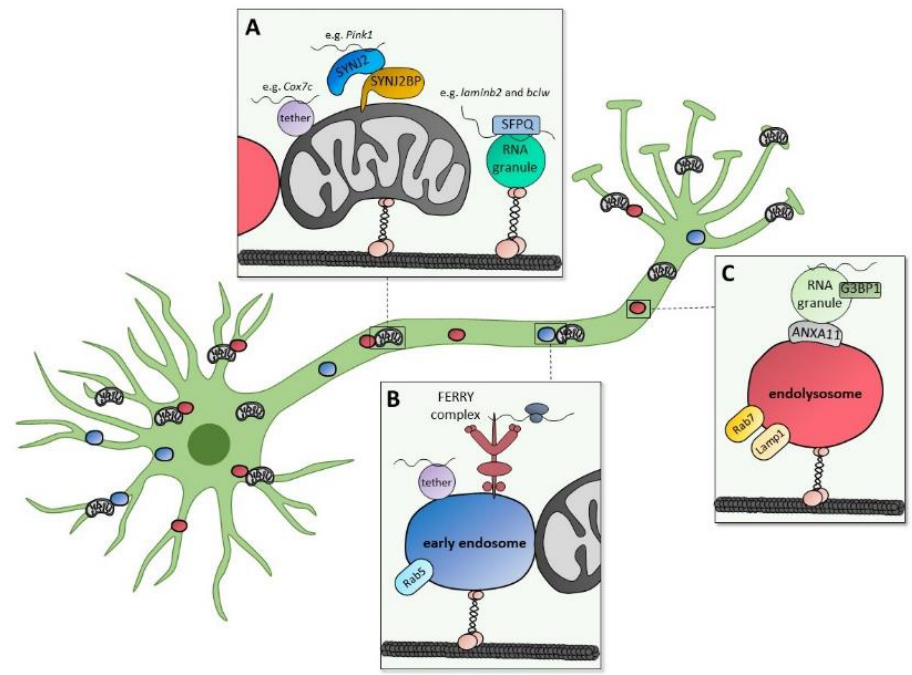
Figure 2. Transport of nuclear-encoded mitochondrial transcripts in neurons. Motor proteins actively transport RNA granules, mitochondria and Rab5-positive early endosomes as well as Rab7- and LAMP1-positive endolysosomes along axons. In this way, nuclear-encoded mitochondrial transcripts that are either part of RNA granules or tethered to the organelles reach distal parts of the neurons allowing for local translation. ( A ) The mitochondrial laminb2 and bclw transcripts are transported in RNA granules via binding to their RBP SFPQ. Cox7c and Pink1 mRNA are tethered to mitochondria. The tethering complex for Pink1 mRNA is composed of SYNJ2BP and SYNJ2. ( B ) Several mRNAs are transported with early endosomes. The FERRY complex localizes to early endosomes and interacts both with the translation machinery and mRNAs that are enriched for nuclear-encoded mitochondrial genes. ( C ) Endolysosomes transport G3BP1-containing RNA granules using ANXA11 as a tether.